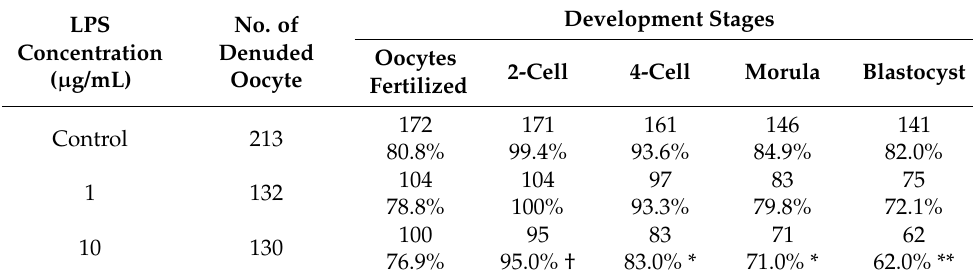
Table 2. Fertilization and development rate in